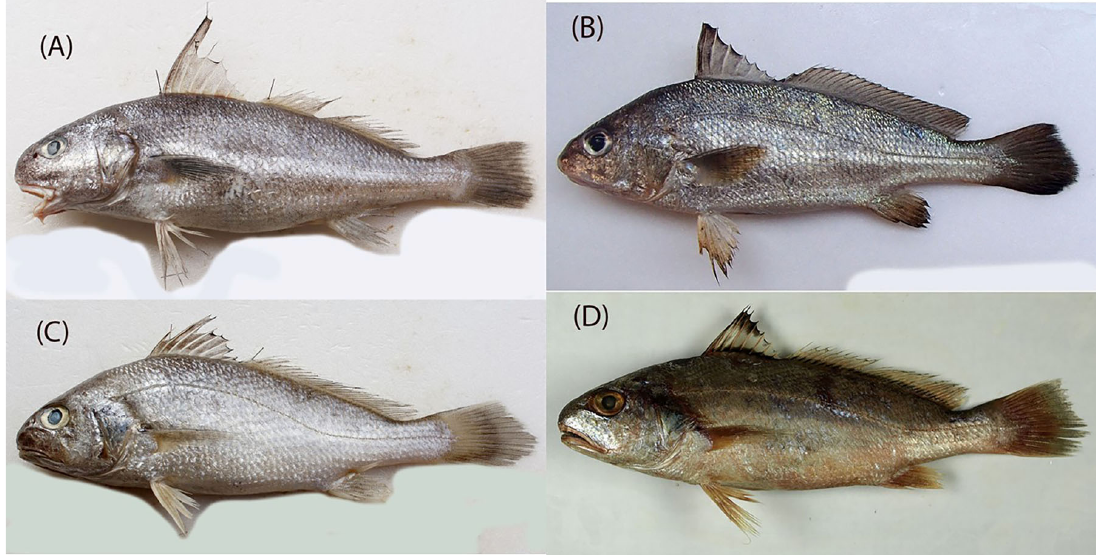
Figure 5. Photographs of Johnius species here described, with specimens deposited in the Taiwan National Museum of Marine Biology and Aquarium (NMMBA). ( A ) Johnius amblycephalus ; NMMB ‐ P37066, 137.09 mm SL; ( B ) Johnius belangerii NMMB ‐ P37067, 139.37 mm SL; ( C ) Johnius borneensis NMMB ‐ P37068, 101.86 mm SL; ( D ) Johnius distinctus NMMB ‐ P37069, 87.27 mm SL.